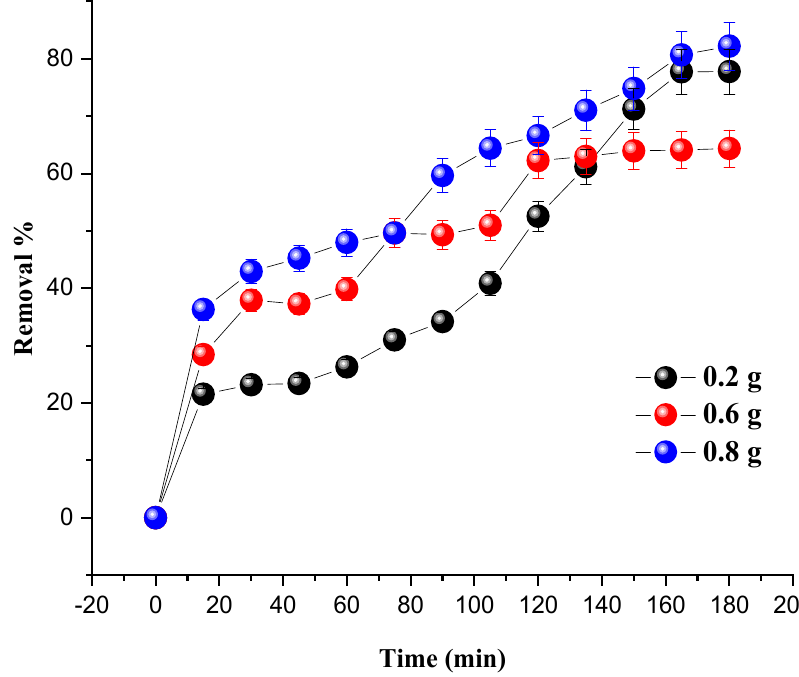
Figure 6. Effect of catalyst loading on MG removal. Reaction conditions: C 0 = 20 mg/L, V H2O2 = 10 mL, pH = 7 and T = 25 °C.